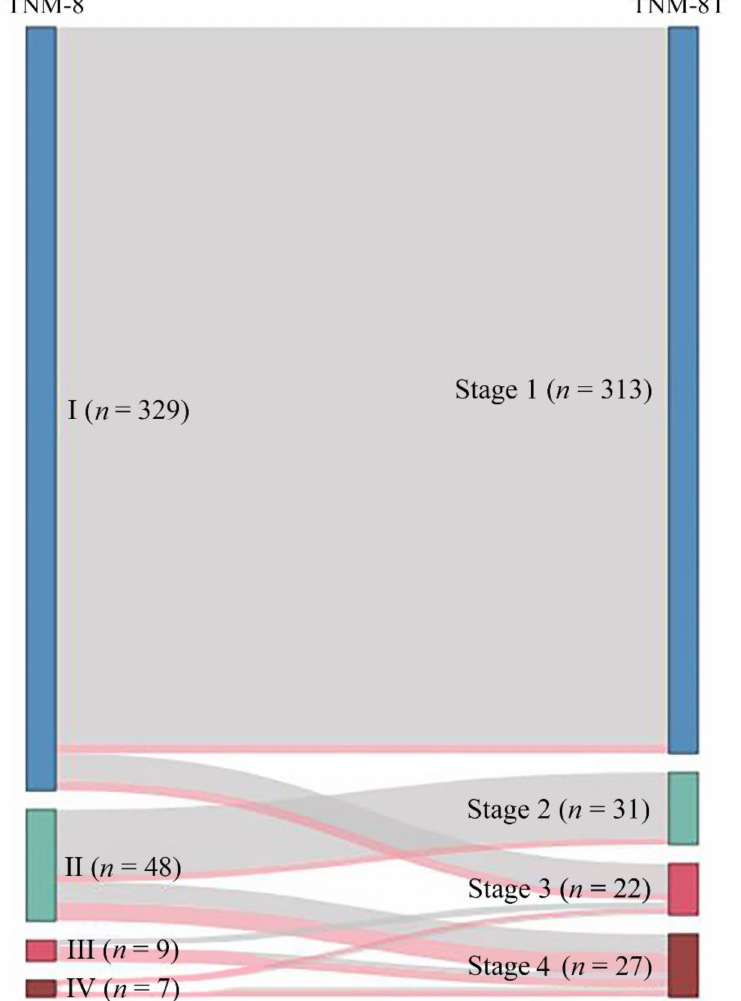
Figure 2. Alluvial flow diagram representing the restaging of patient cohorts from the TNM-8 staging system (Roman numerals) to the TNM-8T staging system (Arabic numerals). Red line indicates deceased